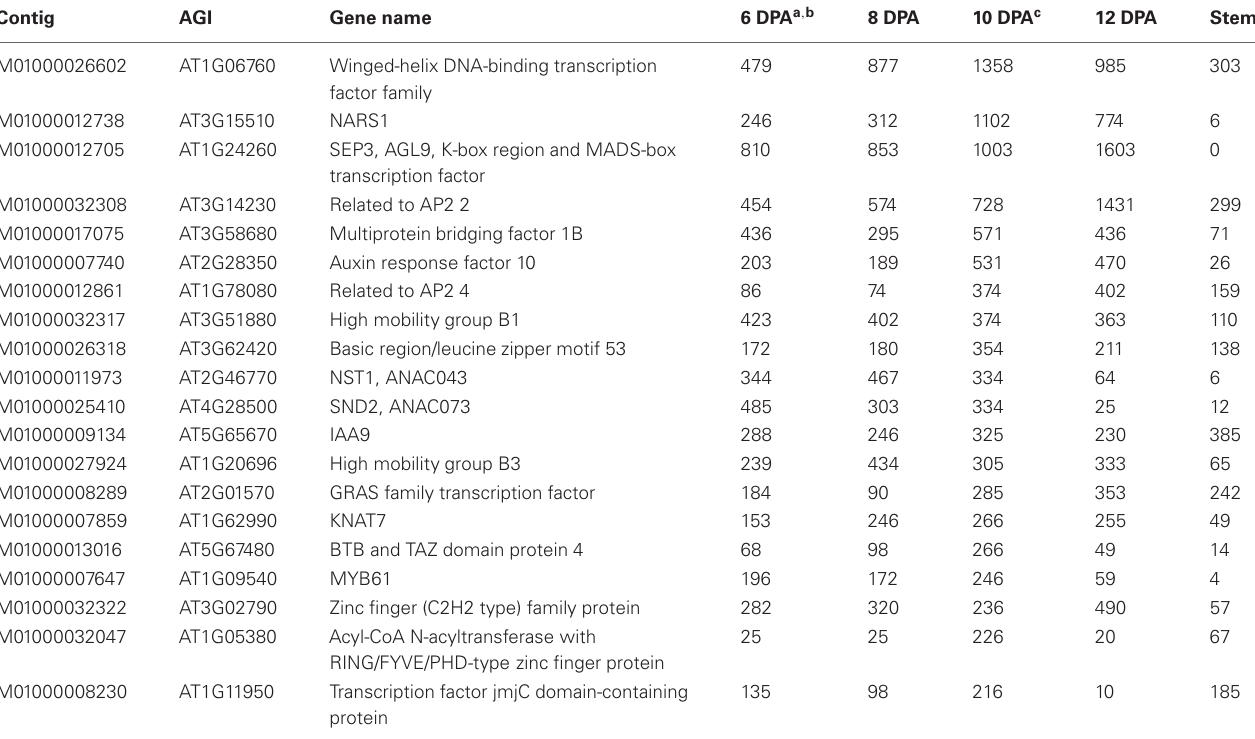
Table 5 | The 20 most abundant transcripts expressed in psyllium mucilaginous layers encoding putative transcription factors.